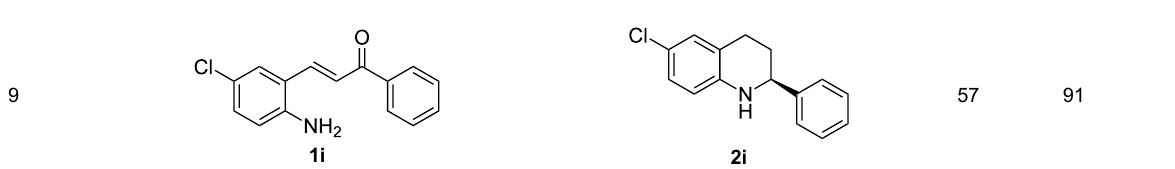
Table 2: Scope of the continuous-flow photocyclization–asymmetric reduction domino sequence. a (continued)